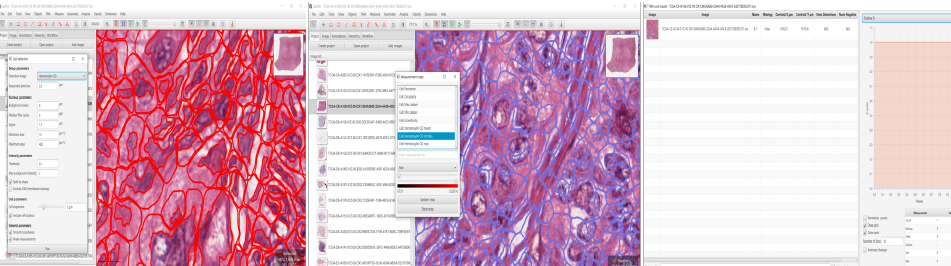
Figure 6. A typical approach used for TMA analysis has the following characteristics (from left to